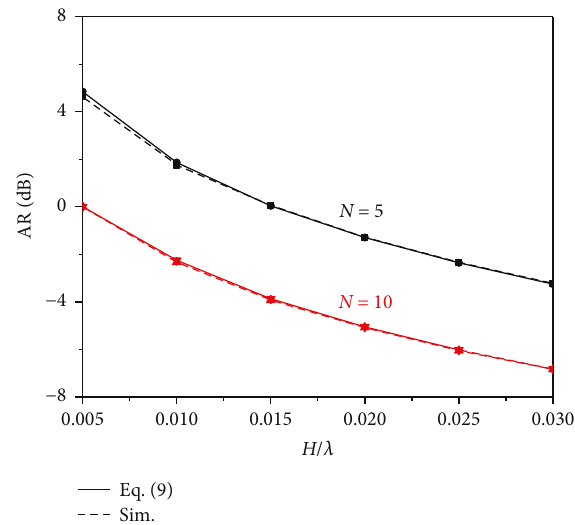
Figure 8: Comparison of the axial ratio of NMHA.